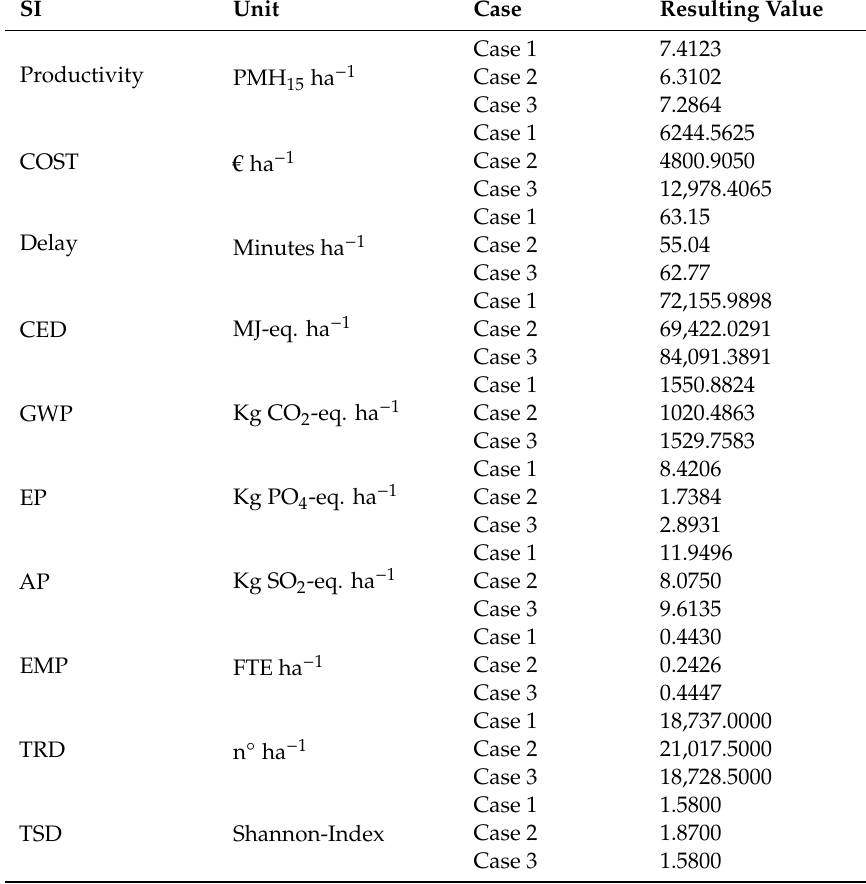
Table 8. Resulting average indicator values per